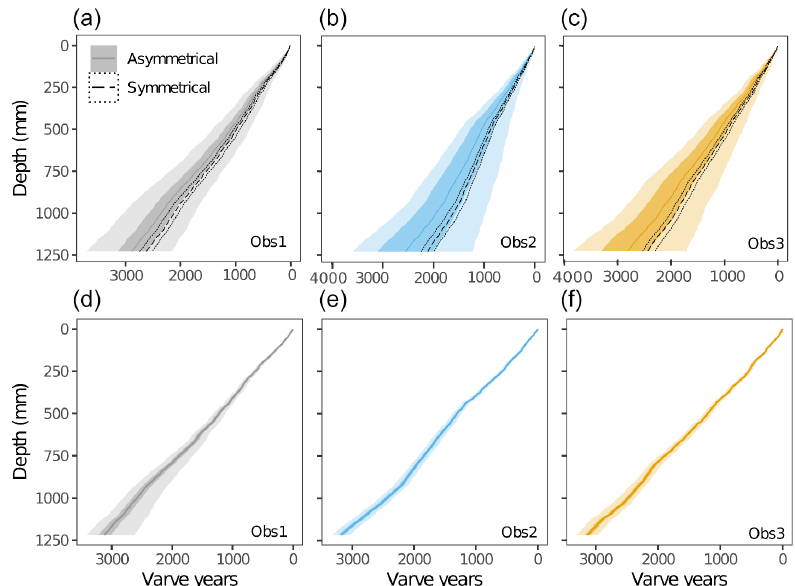
Figure 6. Comparison of varve-only modeled counts by (a,d) observer 1, (b,e) observer 2, and (c,f) observer 3 for dated core COL17-3. In the top row, the modeled varve counts are shown when using symmetrical (dotted envelop) and asymmetrical (shaded envelop) priors. For the symmetrical uncertainty, the median (dashed line) and the 97.5% (dotted region) high-density regions are depicted. For the asymmetrical uncertainty, the median (darkest line), 75% (darkest shaded region), and 97.5% (lightest shaded region) high-density regions are depicted. In the bottom row, the integrated varve and radiometric models are